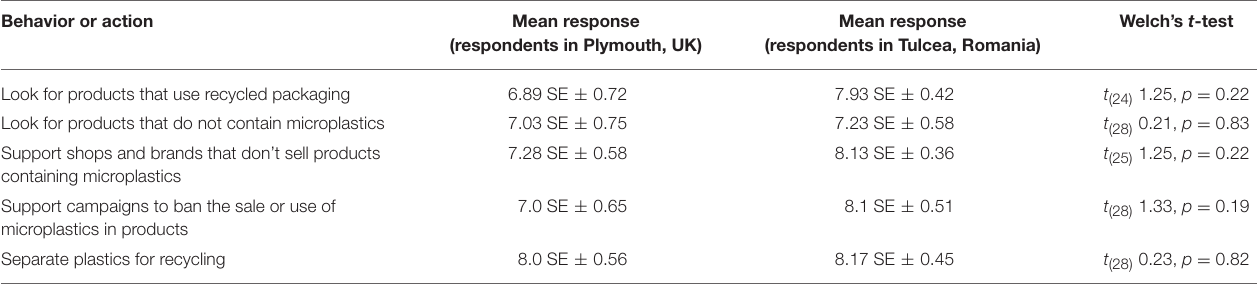
TABLE 10 | Mean intended frequency reported by participants at each location, to undertake behavior options in the future, including Welch’s t -test of difference between